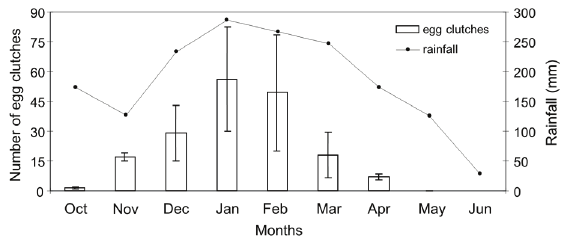
Figure 5 - Seasonal variation in monthly number of egg clutches of Allobates subfolionidificans and precipitation throughout the study period in Rio Branco, western Amazonia. Vertical bars represent standard